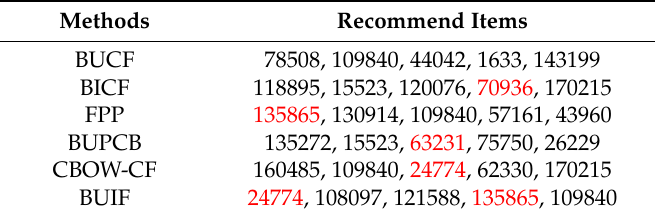
Table 6. The recommendation results of above methods for user